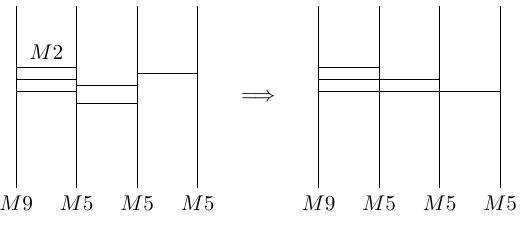
Figure 2 . All the M 2 branes must form E-string-like bound states in the limit m = ǫ + . with theirs in the small q = exp(2 π i τ ) expansion. Furthermore, the partition functions with base degrees ( n b ) = (0 , n 1 , n 2 ) can also be computed with the multi-M-string setup where M 2 branes are suspended between three parallel M 5 branes, as discussed in